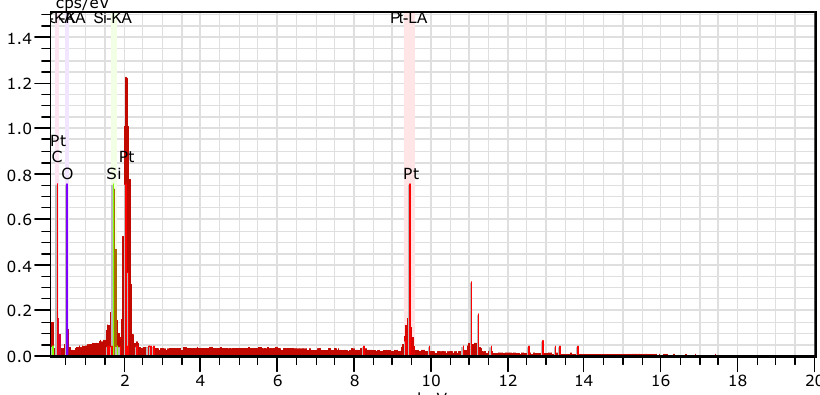
Figure 11. EDX image presented an elemental spectrum of electroless deposited Pt layer on the track obtained by ns-laser ablation of PDMS (wavelength of 266 nm, fluence 35.37 J.cm −2 ) in water, confirming that the metal crystals are truly platinum.